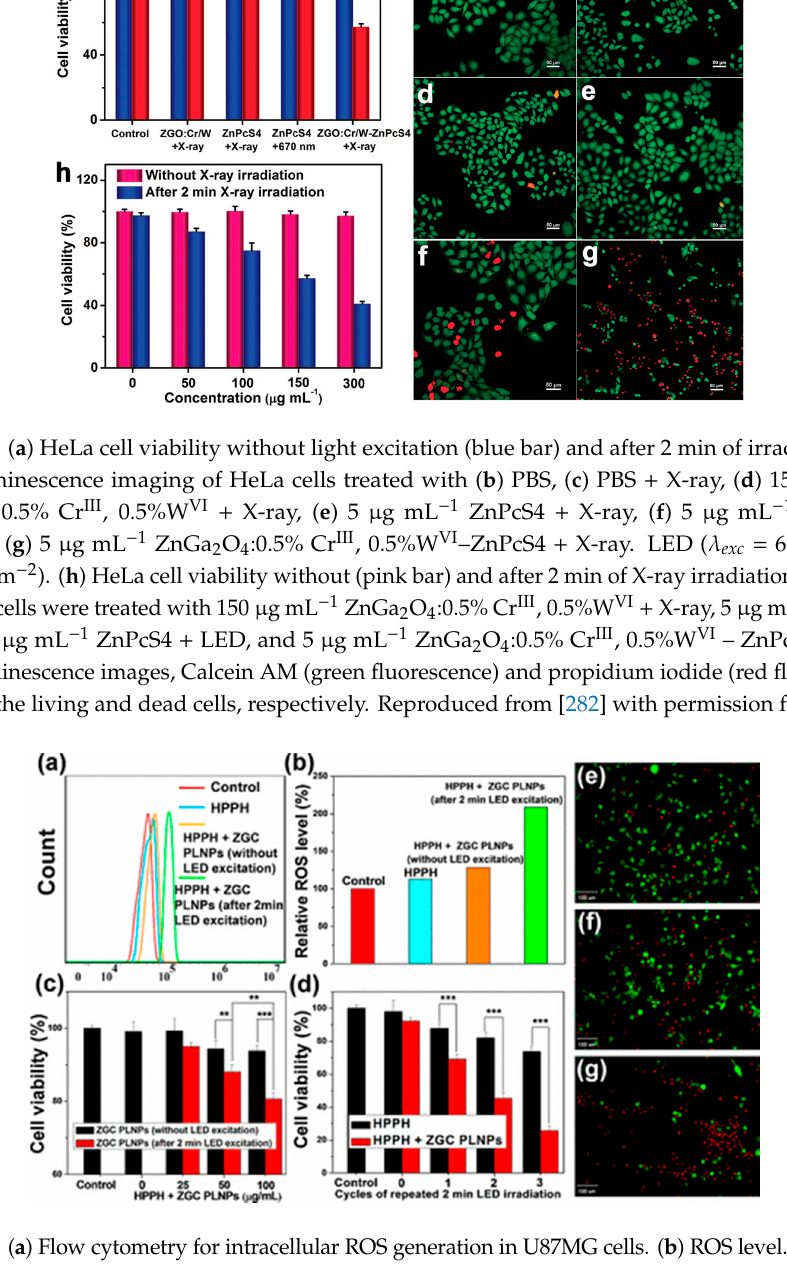
Figure 20. ( a ) Flow cytometry for intracellular ROS generation in U87MG cells. ( b ) ROS level. ( c ) U87MG cell viability after treatment HPPH and HPPH + different concentrations of with ZnGa 2 O 4 :0.4% Cr III without (black bars) or with (red bars) light excitation. ( d ) U87MG cell viability after treatment HPPH and ZnGa 2 O 4 :0.4% Cr III –HPPH after several cycles of irradiation. Luminescence imaging of U87MG cells treated with 1 μ g mL ‐ 1 HPPH + 50 μ g mL ‐ 1 ZnGa 2 O 4 :0.4% Cr III after ( e ) one, ( f ) two or ( g ) three cycles of 2 min irradiation. In the luminescence images, Calcein AM (green fluorescence) and propidium iodide (red fluorescence) indicates the living and dead cells, respectively. Reprinted with permission from [279]. Copyright (2017) American Chemical Society.